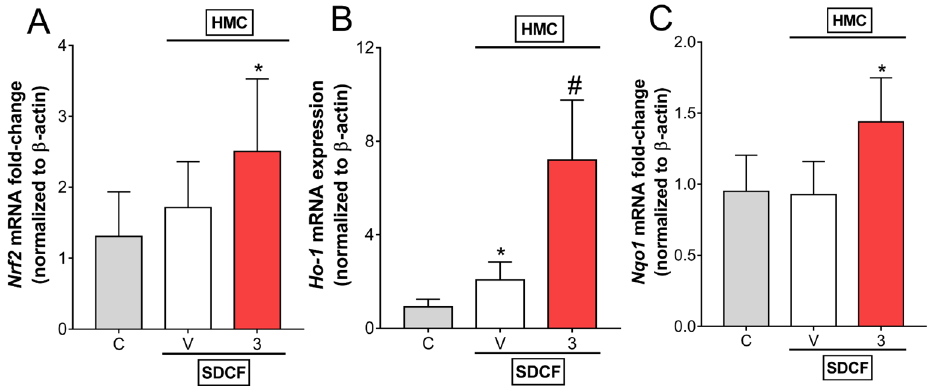
Figure 7 . HMC induces Nrf2 signaling in renal tissue. Kidney samples were collected 24 h after the administration of SDCF for the evaluation of Nrf2 ( A ), Ho-1 ( B ), and Nqo1 ( C ) mRNA expression. Results are expressed as mean ± SD, n = 6 mice per group per experiment, and are representative of two independent experiments. * p < 0.05 vs. control ( C ) group; # p < 0.05 vs. vehicle (V) treated group; one ANOVA followed by Tukey’s post hoc test.